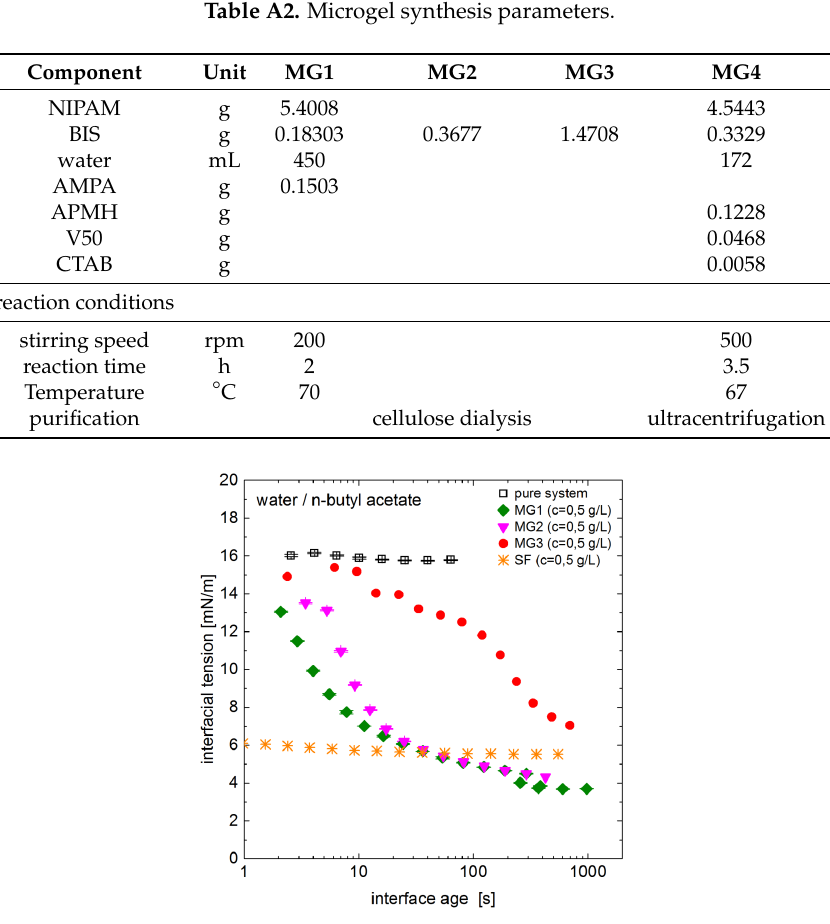
Figure A1. Interfacial tension of the water/ n -butyl acetate system with different microgels and surfactant, measured by drop volume tensiometry with DVT50 from Krüss (Hamburg,